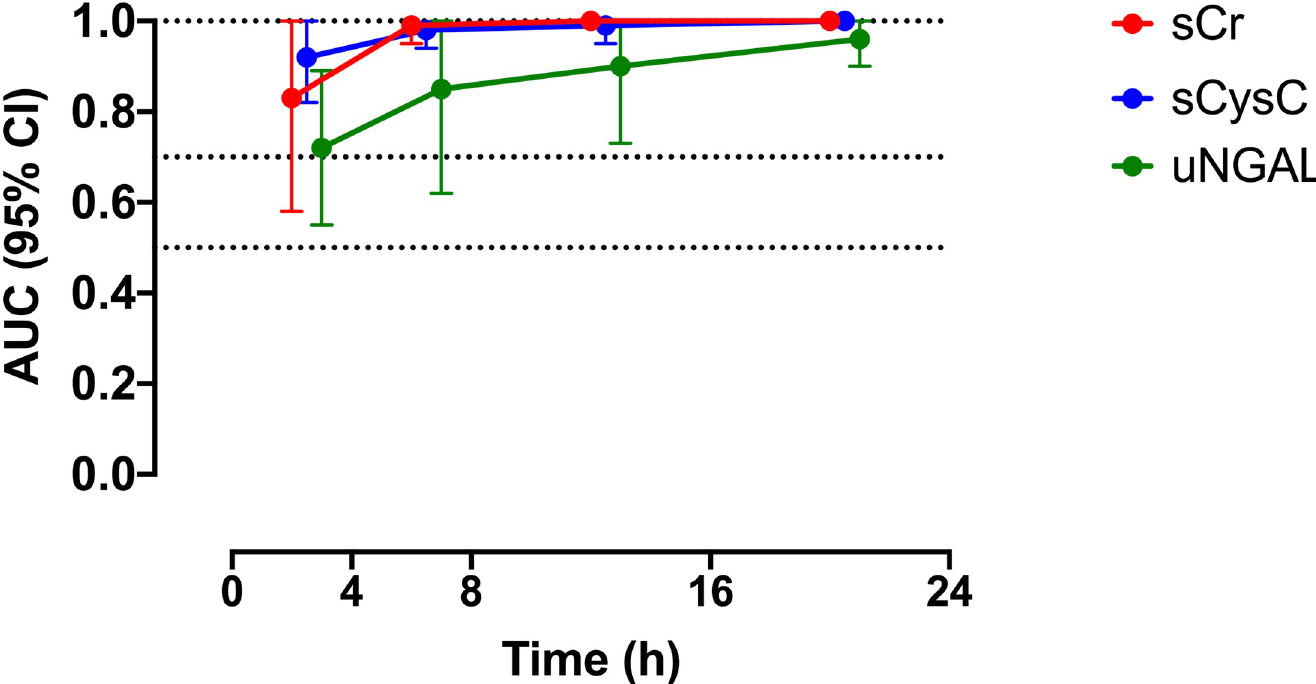
Fig 5. Plots of the AUC-ROCs versus time for the best biomarkers in detecting moderate/severe AKI versus no AKI/mild AKI, including serum creatinine (sCr; red line), serum cystatin C (sCysC; blue line), and urinary neutrophil gelatinase-associated lipocalin (uNGAL; green line).